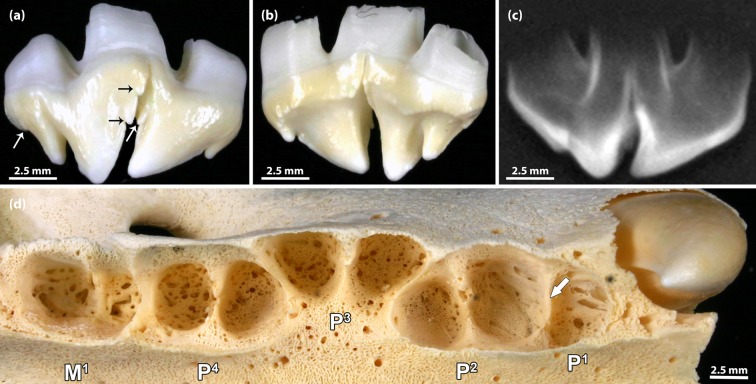
Incompletely fused right P1 and P2 in a 1-month-old male Eastern Atlantic harbor seal (Phoca vitulina vitulina, specimen ZIK 27291).(a) Buccal view (mesial to the right) of the incompletely fused teeth (crowns separate, only roots fused). Note small cusps (some marked by arrows) at the mesial and distal crown edges of both teeth. (b) Palatal view of the incompletely fused teeth (mesial to the left). (c) Radiograph of the specimen, showing that the crowns of the two teeth are separate and only the roots are partly fused. (d) Alveolar pattern of right maxillary postcanines. The number of alveoli is normal, as the fused root is situated in the anterior (mesial) socket of the P2. The septum marked by the arrow must be classified as an interradicular septum rather than an interdental septum normally present in this location.